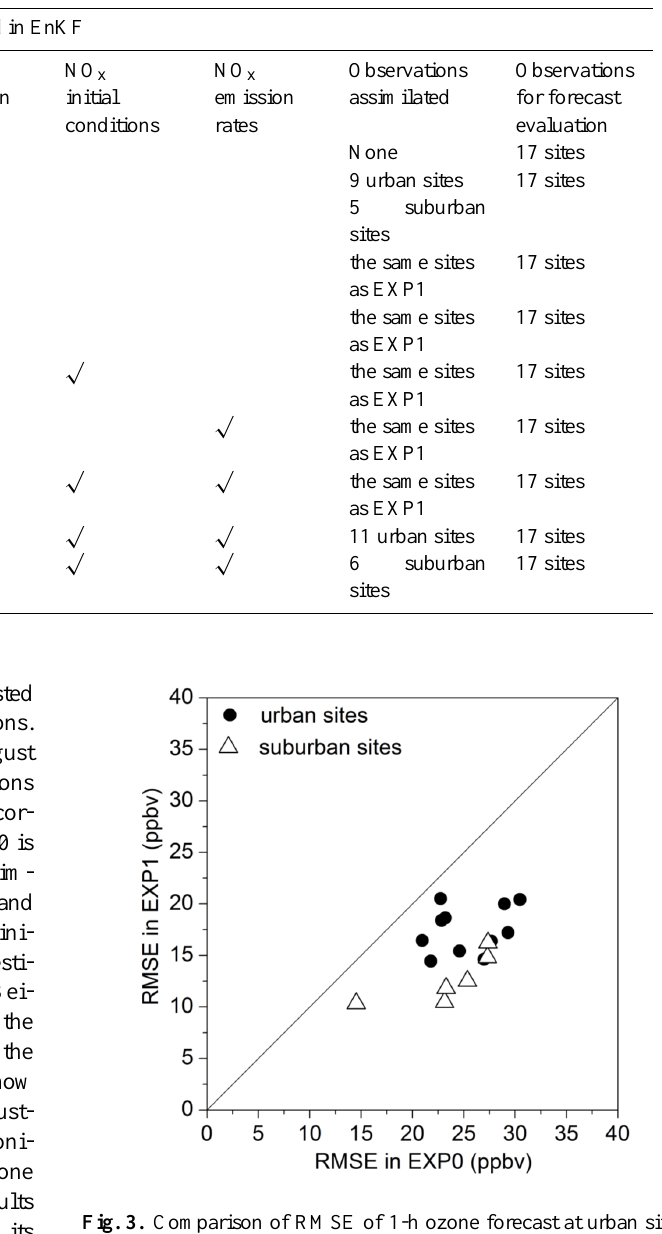
Table 1. Experiments designed for evaluating the performance of different data assimilation strategies.